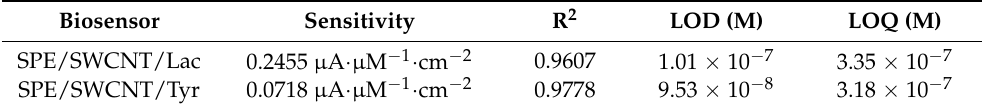
Table 3. Linear dependence equation, R 2 , LOD and LOQ for the two modified electrodes. Biosensor